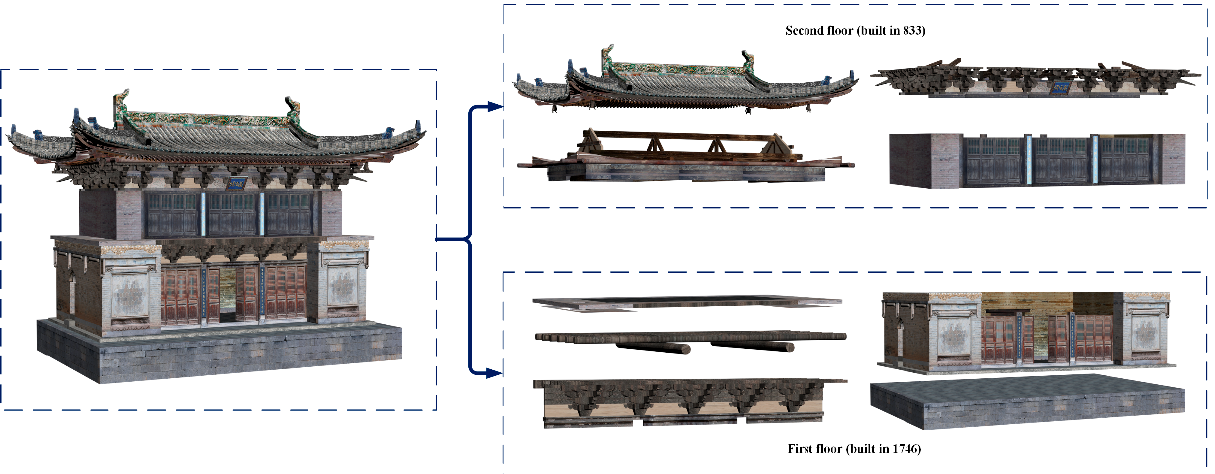
Figure 11. Three-dimensional model of the Sutra Pavilion.